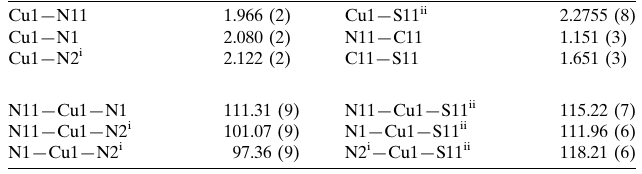
Selected geometric parameters (A˚ , (cid:1)